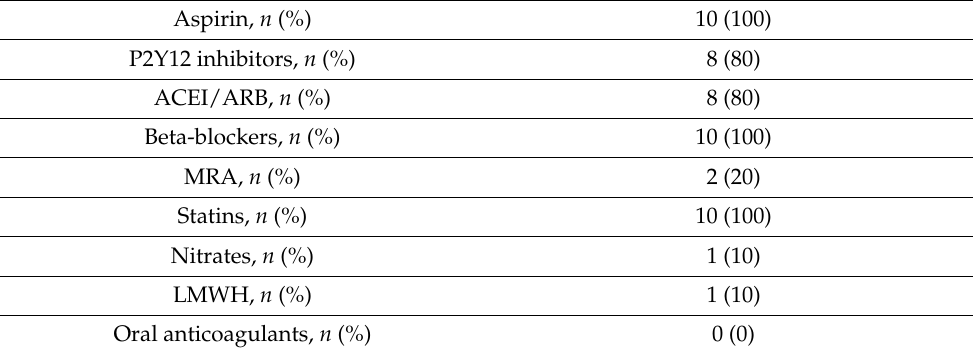
Table 3. Medications at